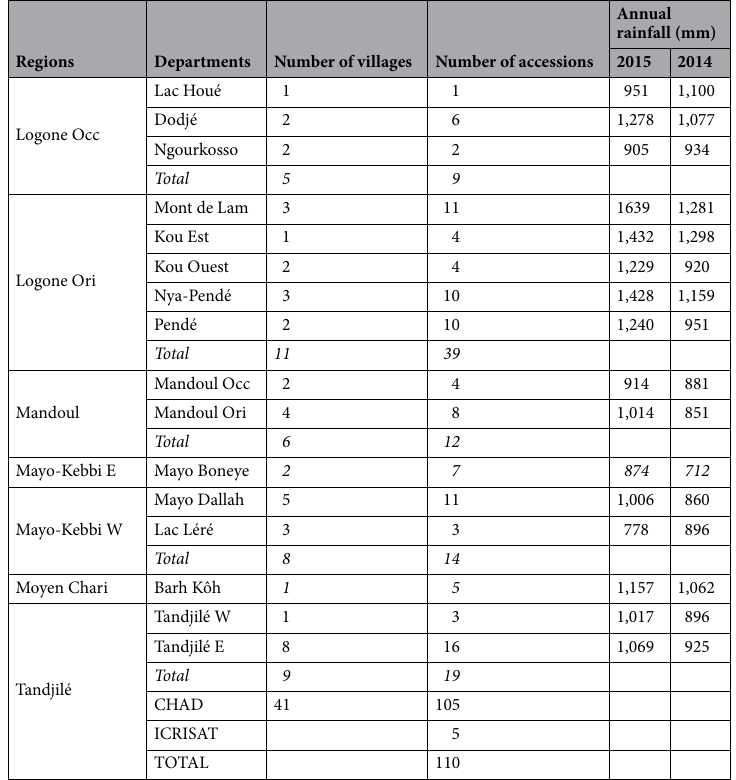
Table 1. Rainfall, regional distribution, and origins of sweet sorghum accessions used in